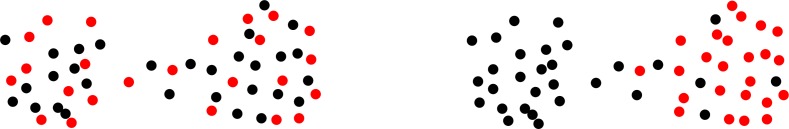
Variance can be used as a proxy for unsupervised feature selection but does not take into account the underlying metric structure of the data.In the figure a point cloud is labeled according to two binary features with equal variance. However, only the feature on the right shows a large degree of consistency with the metric structure of the data. Manifold learning approaches to feature selection prioritize features according to the degree of consistency with the underlying metric structure of the data.